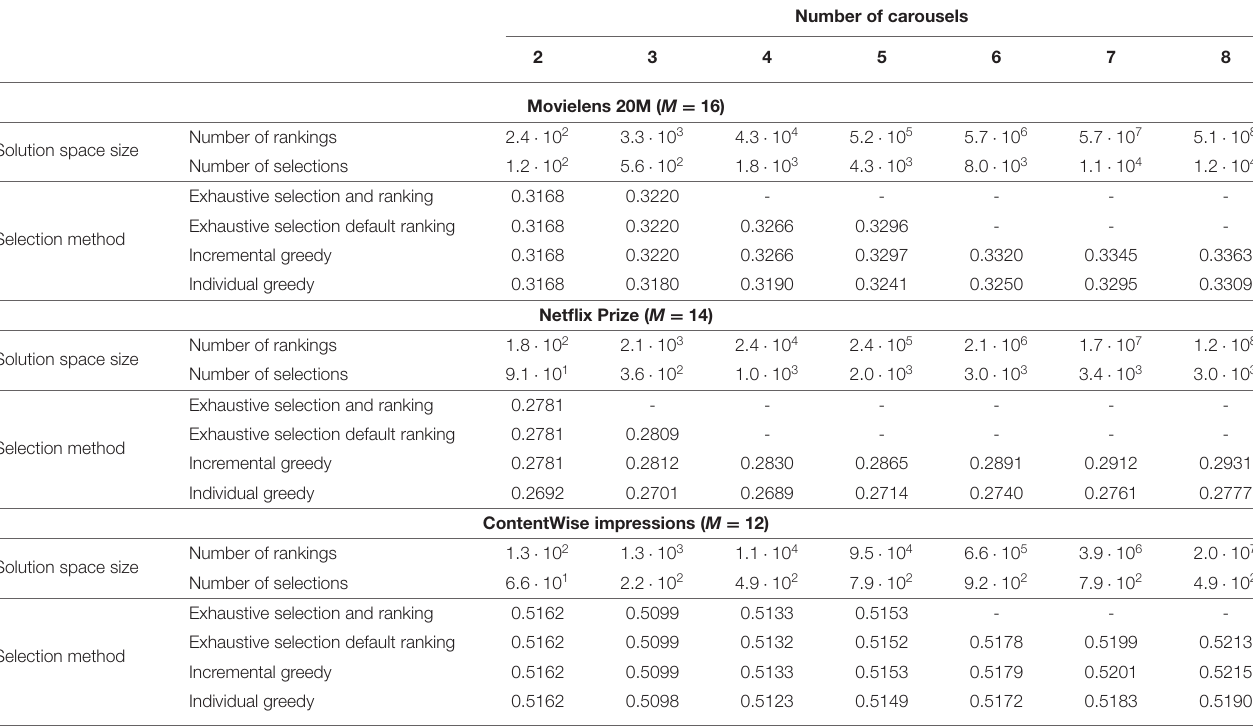
TABLE 5 | Comparison of the NDCG at 10 of the layout selected according to the two proposed greedy strategies and compared to the exhaustive search of all possible model selections and rankings.